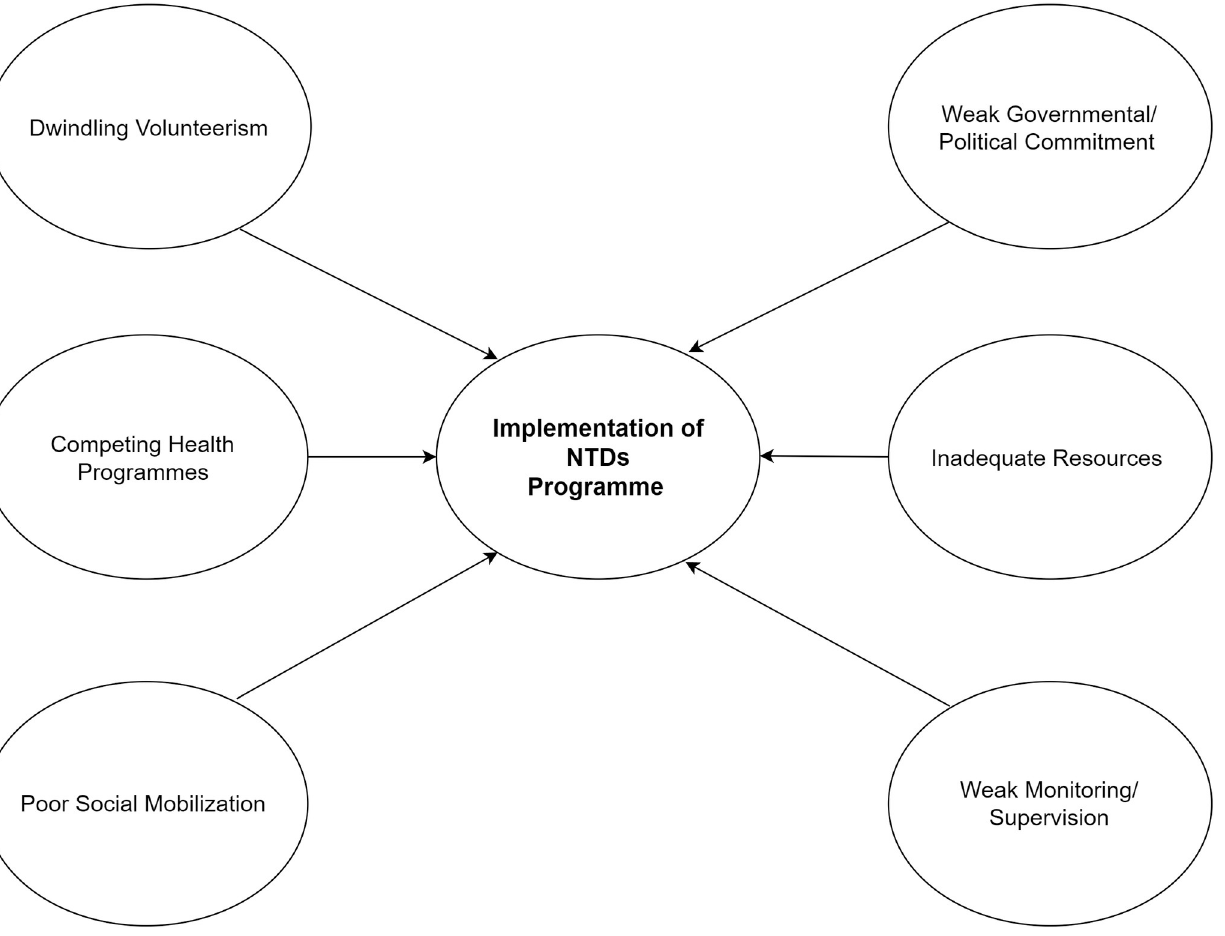
Fig 1. Summary of findings/themes emanating from study.